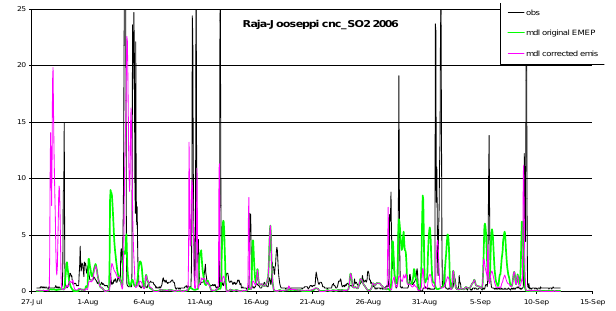
Figure 8. Extraction of time series of modelled and measured SO2 concentrations at Raja-Jooseppi station, 2006, [ μ g SO2 m-3]. Fig. 8. Extraction of time series of modelled and measured SO 2 concentrations at Raja-Jooseppi station, 2006, [µgSO 2 m − 3 ].